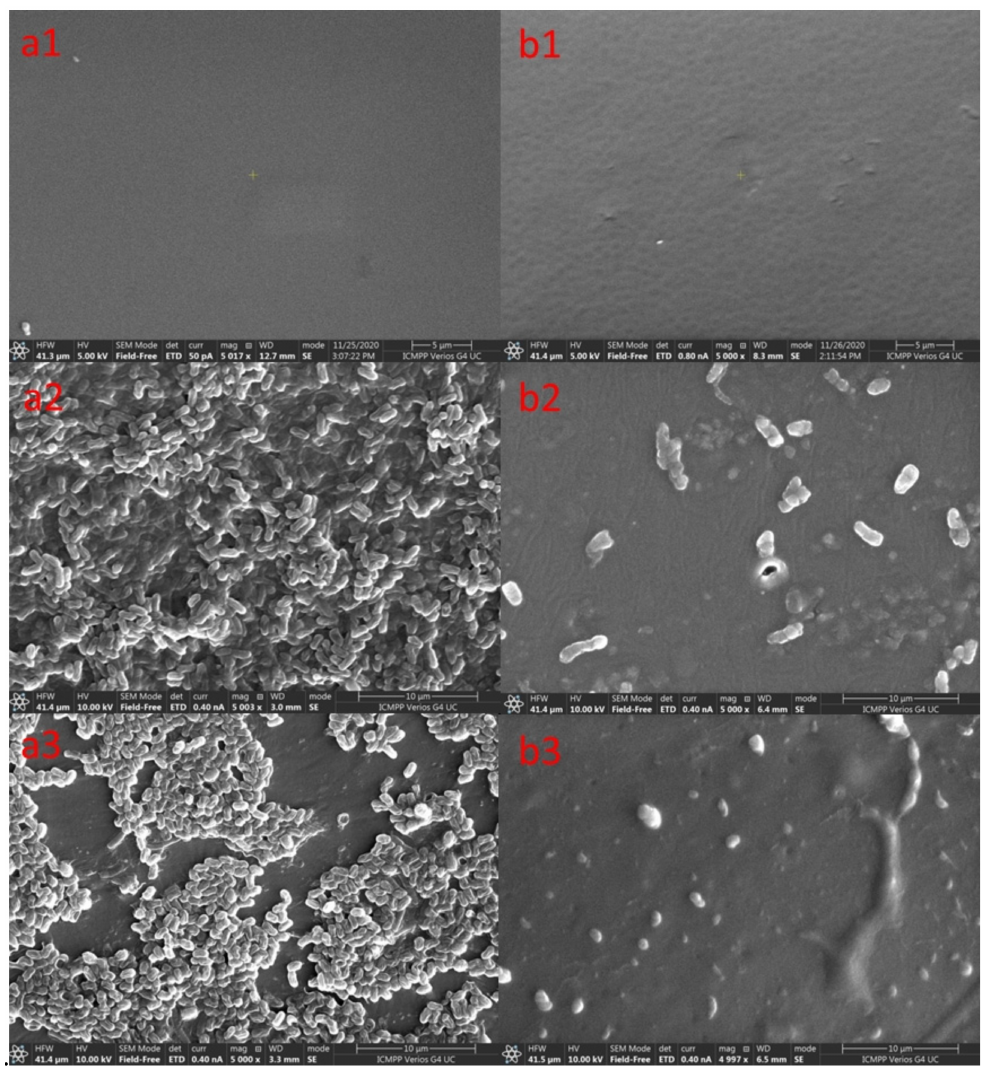
Figure 8. SEM surfaces images of CR-PNAC-18-0 ( a ) and CR-PNAC-18-75 ( b ) samples at 5 ( up ) and 10 ( below ) µ m: ( a1 ) and ( b1 ), before incubation; ( a2 ) and ( b2 ) after in vitro incubation with S. pneumoniae for 4 weeks; ( a3 ) and ( b3 ) after in vivo incubation for 4